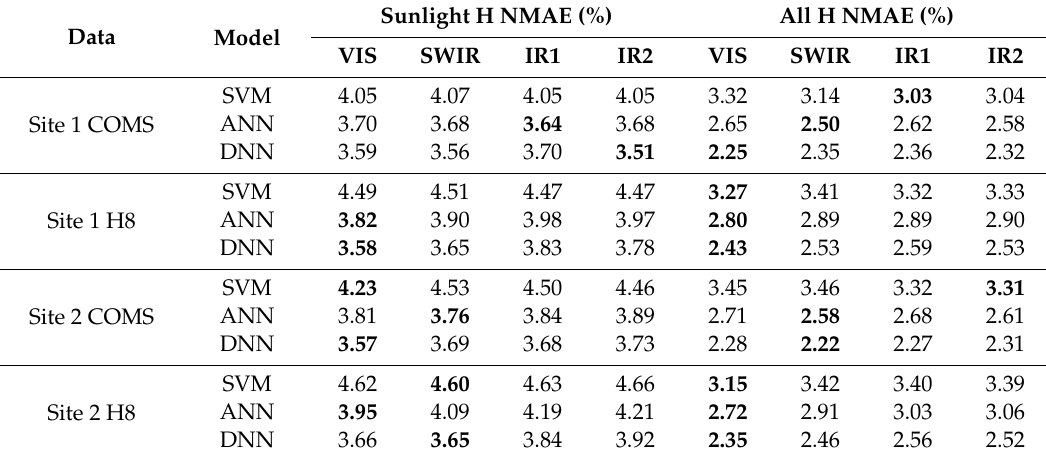
Table 5. NMAE results from 1 h-ahead PV power forecast for COMS and H8 datasets using three forecast models in “Sunlight H” and “All H” time frames (bold text indicates the lowest NMAE values for each forecast